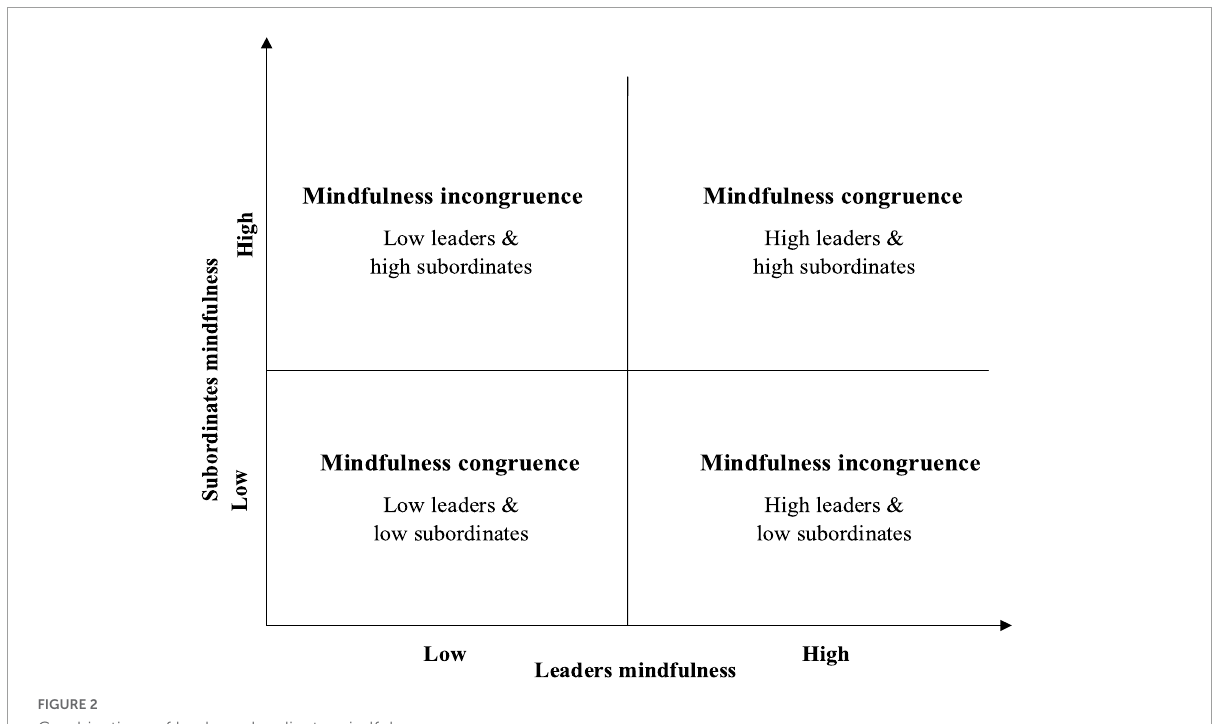
FIGURE2 Combinations of leader-subordinate